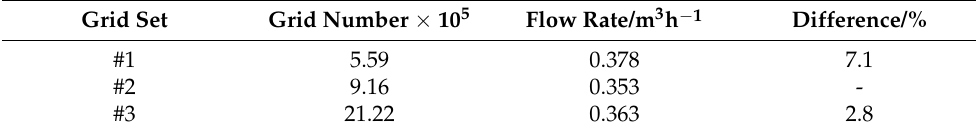
Figure 2. Mesh of the improved V-ball valve. Table 1. Flow rate of the improved V-ball valve with the different grid numbers.